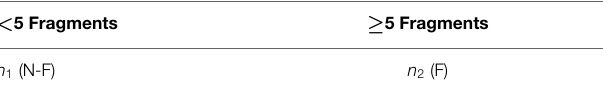
TABLE 3 | Criteria 2 (C2)